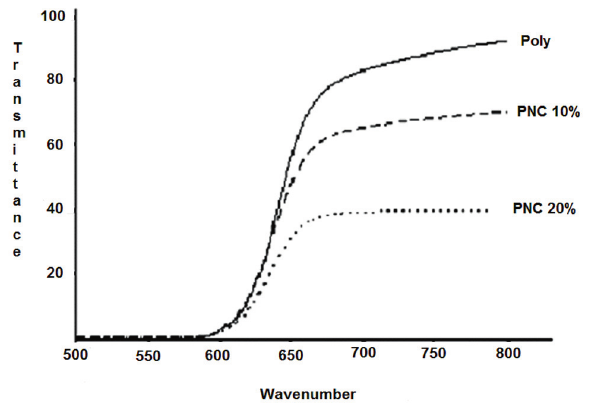
Figure 8. TGA thermograms of neat PAI 5 and PAI- nanocomposite films 5a and 5b